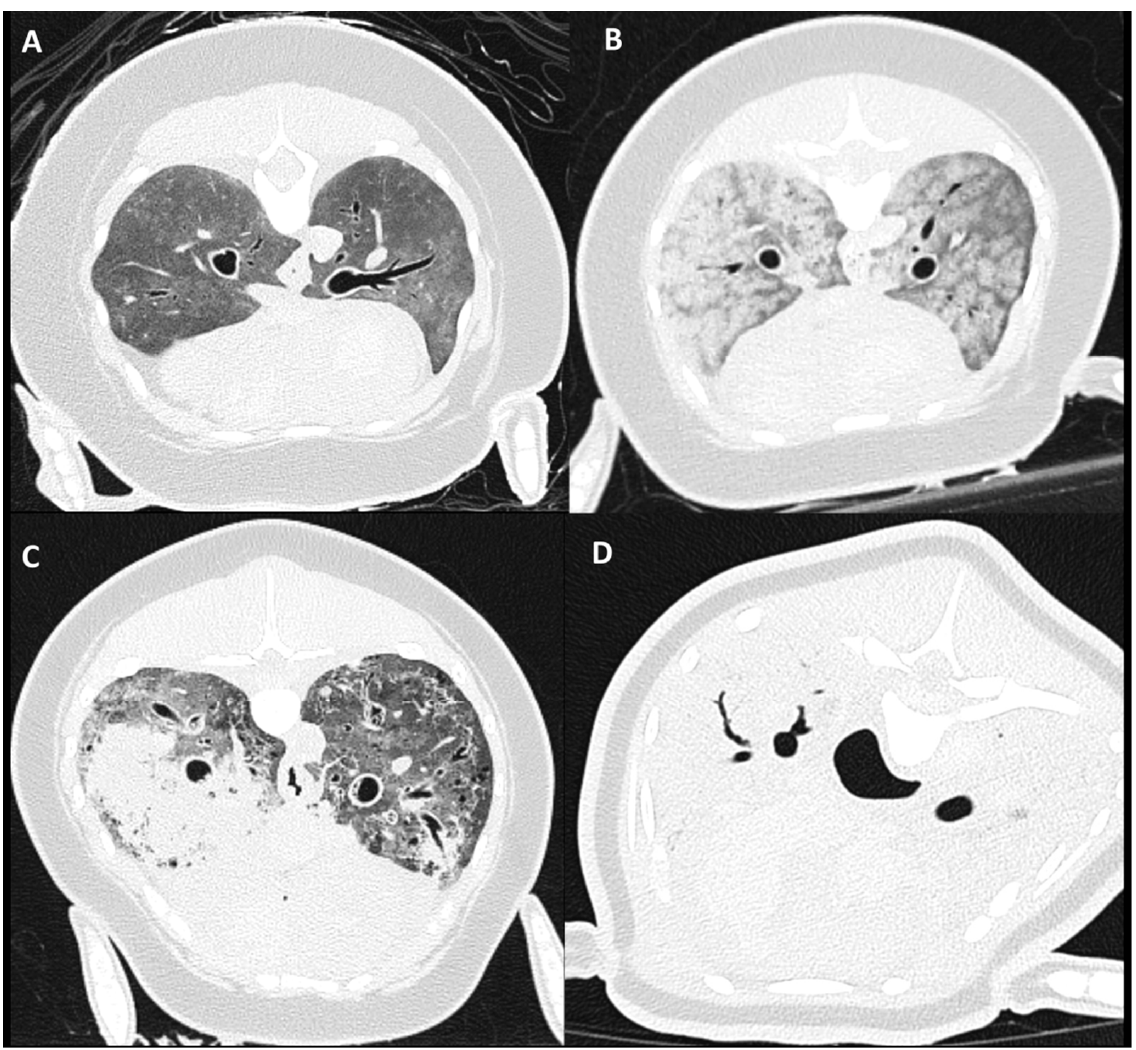
Figure 3. Pulmonary soft tissue attenuation score on PMCT. Clockwise presentation of: ( A ) mild: minimal focal, heterogeneous PSTA affecting <30% of the lungs, ( B , C ) moderate: diffuse, heteroge- neous PSTA, including focal homogeneous PSTA affecting 30–75% of the lung parenchyma, and ( D ) severe: diffuse, homogeneous PSTA, affecting >75% of the lung parenchyma.